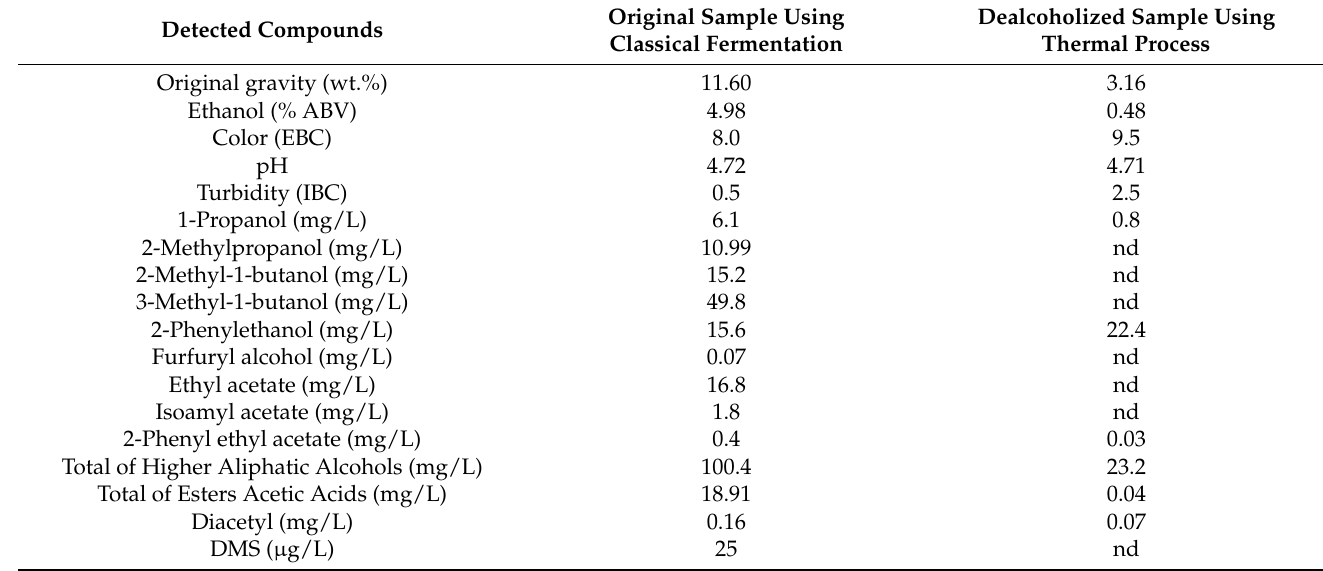
Table 3. Aromatic compounds and turbidity of the final product of alcoholic and dealcoholized beer in various fermentation conditions, determined by GC.